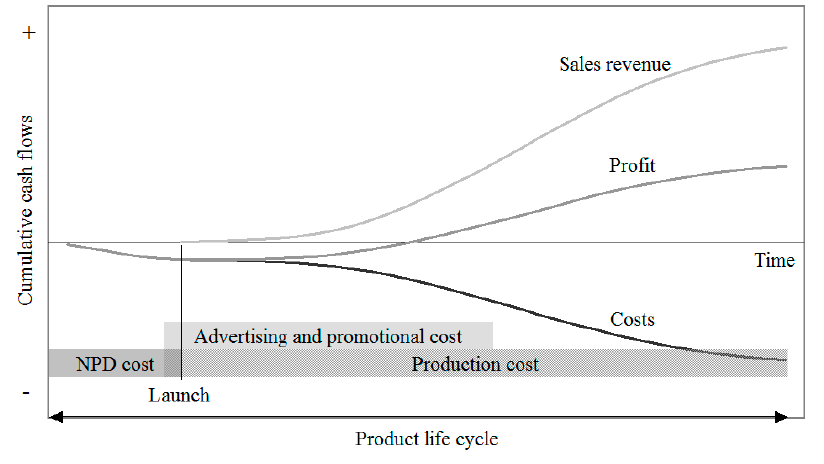
Figure 1. Product development cash flow.